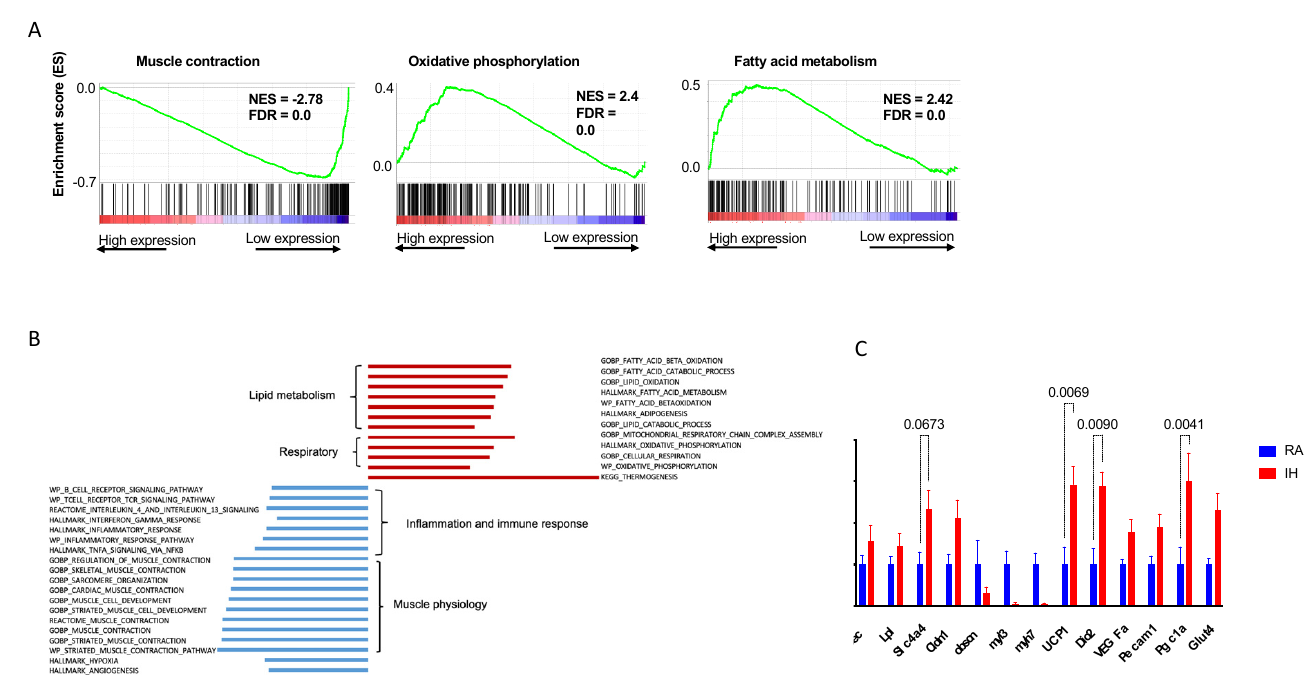
Figure 5. Chronic intermittent hypoxia leads to global transcriptomic changes in BAT. ( A ) Example of pathways up/downregulated in IH-exposed BAT. ( B ) The most altered pathways between IH and room air-exposed BAT. ( C ) Expression of selected genes in signaling pathways relevant to brown adipose tissue (left to right): lipid droplet structure (Cidec, Lpl, Slc4a4, Cldn1), myogenesis (obscn, myl3, myh7), thermogenesis (UCP1, Dio2), angiogenesis (Vegfa, Pecam1, PGC1a), and glucose utilization (Glut4).